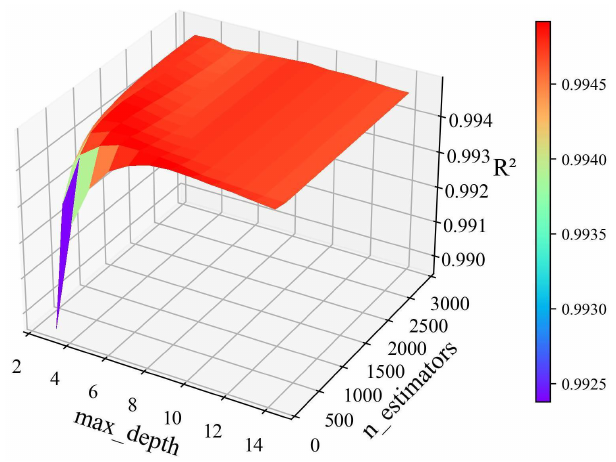
Figure 9. HPO of XGBoost model after Kwon cleaning.